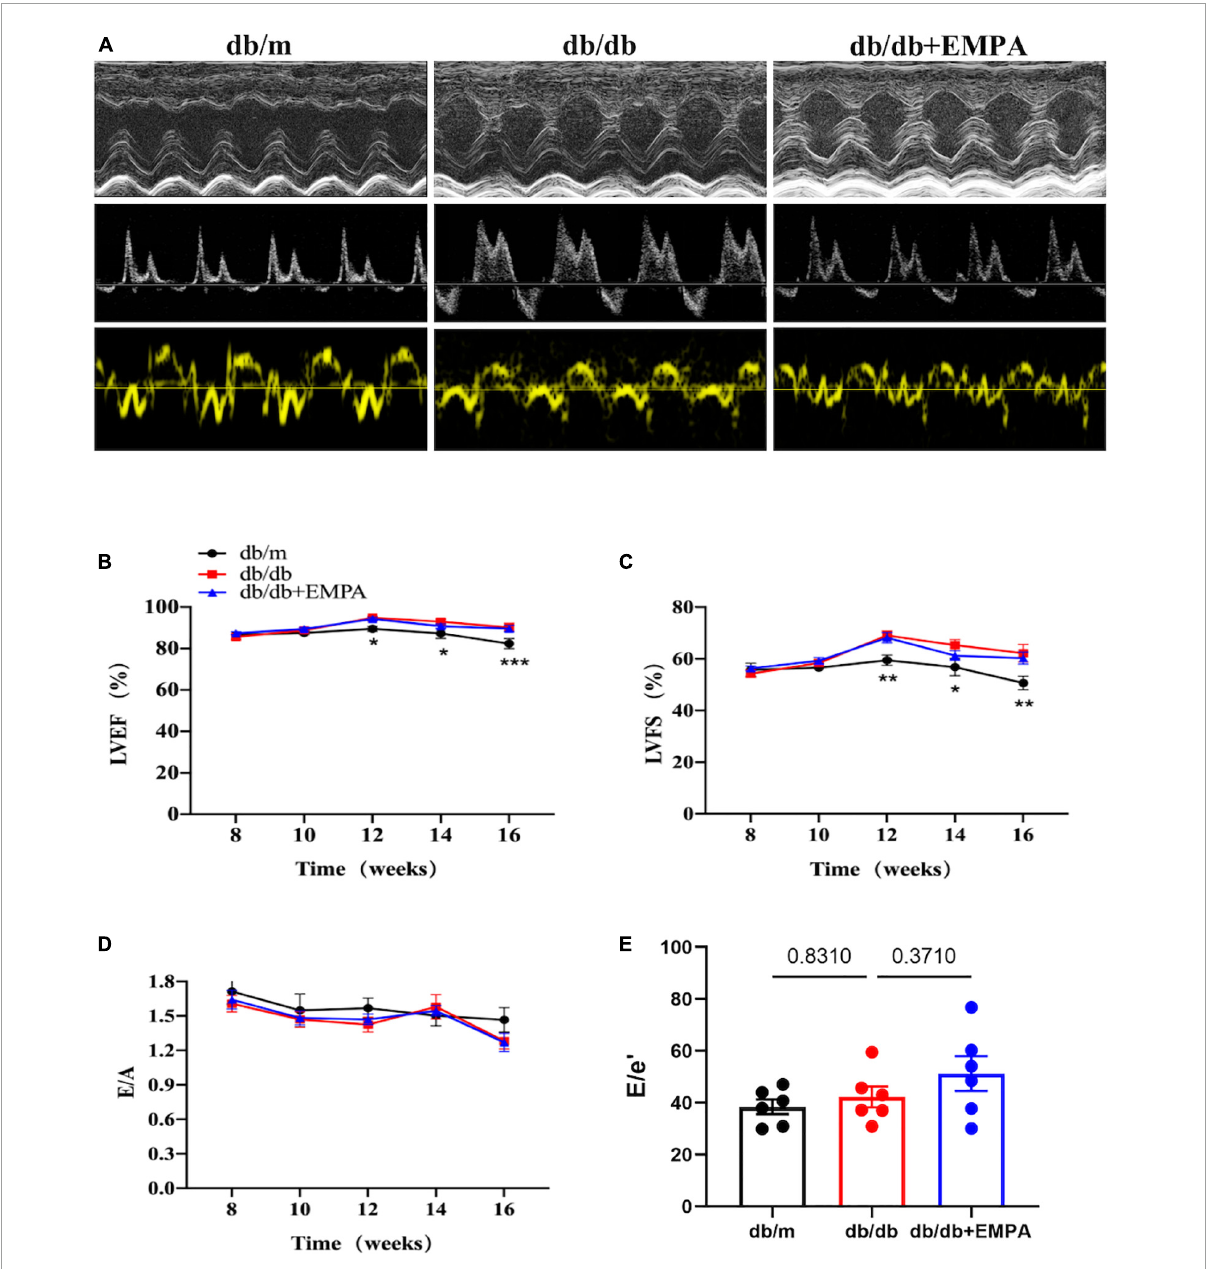
FIGURE2 Effects of empagliflozin treatment on cardiac function in db/db mice. (A) Representative M-mode (top), pulse-wave Doppler (middle) and Tissue Doppler (bottom) tracings from different experimental groups. (B) Left ventricular ejection fraction (LVEF) of different experimental groups over time. (C) Left ventricular fractional shortening (LVFS) of different experimental groups over time. (B,C) The db/m group vs. the db/db group vs. the db/db + EMPA group = 6 vs. 10 vs. 11. (D) E/A ratio of different experimental groups over time, n = 6 per group. (E) E/e (cid:48) ratio of different experimental groups of 16 weeks of age, n = 6 per group. Data are represented as the means ± SEM, * p < 0.05, ** p < 0.01 and *** p < 0.001 the db/m group vs. the db/db group.